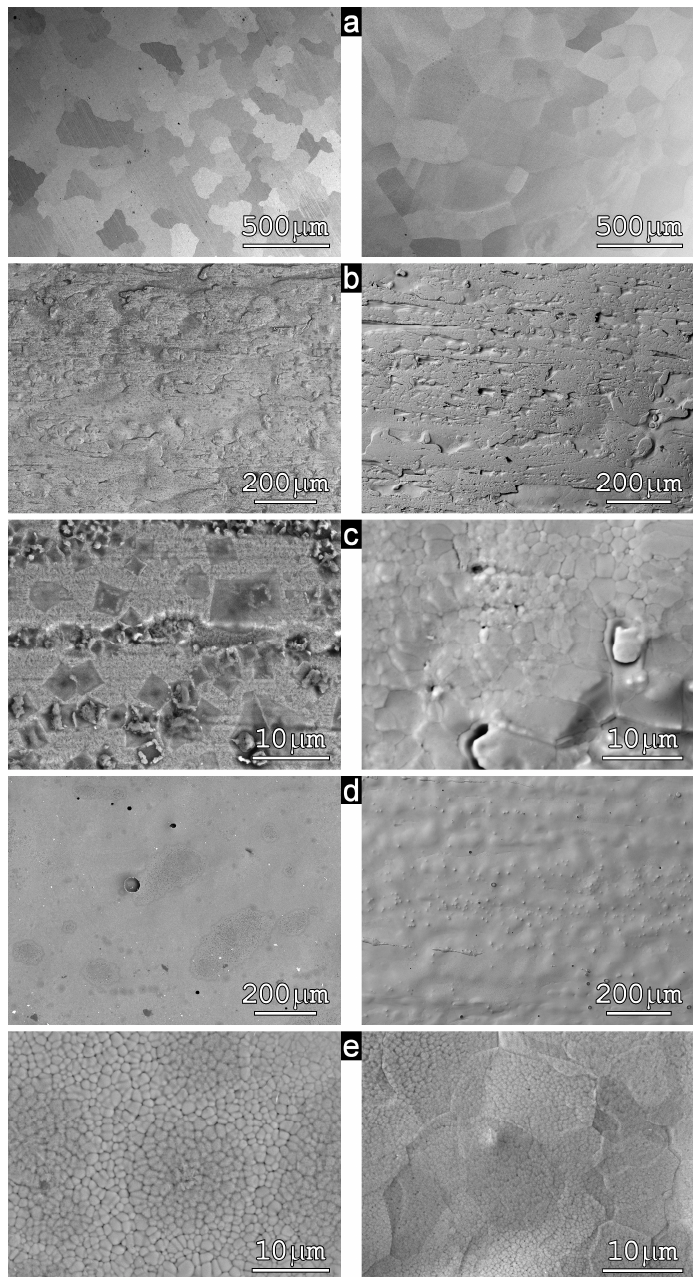
Figure 3. SEM micrographs of the Fe 2 MnSi (left panel) and Fe 2 MnAl (right panel) samples prepared by arc melting: DS, DA ( a ) and by planar flow casting-wheel side: RS, RA ( b , c ), air side: RS, RA ( d , e ). Details are described in the text.